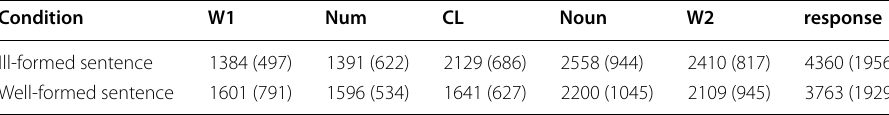
CL Mass Noun structure per sentence types + +